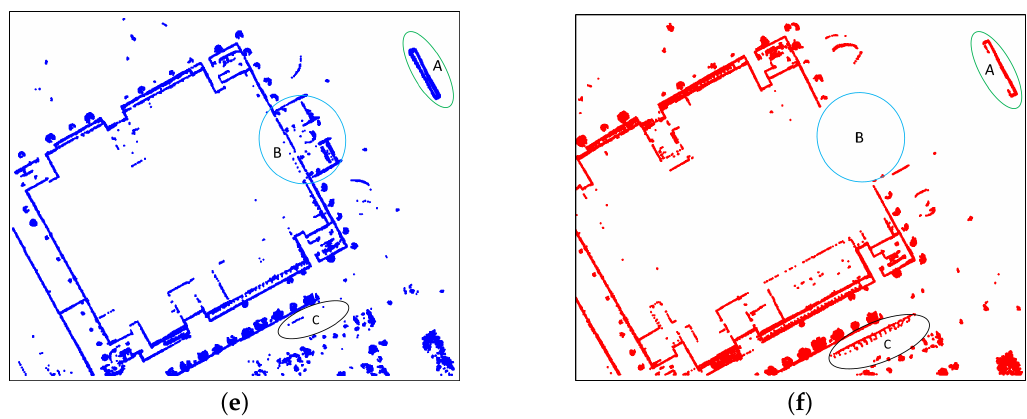
Figure 15. Comparison of mapping details from different methods. ( a ) Our map of scene #1. ( b ) Cartographer’s map of scene #1. ( c ) Our map of scene #2. ( d ) Cartographer’s map of scene #2. ( e ) Our map of scene #3. ( f ) Cartographer’s map of scene